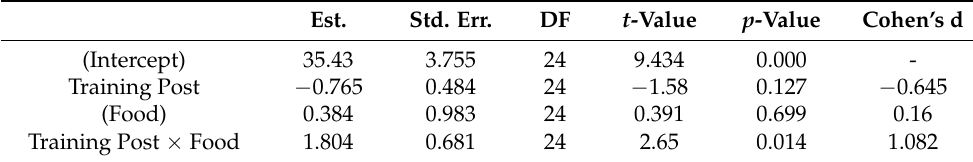
Table 3. Coefficients of the linear mixed effects model (LME) fitted to the knee extension data. Estimates (Est.) correspond to one-repetition maxima [kg] and respective changes. Est. Std. Err. DF t -Value p -Value Cohen’s d (Intercept) 35.43 3.755 24 9.434 0.000 - Training Post − 0.765 0.484 24 − 1.58 0.127 − 0.645 (Food) 0.384 Training Post ×